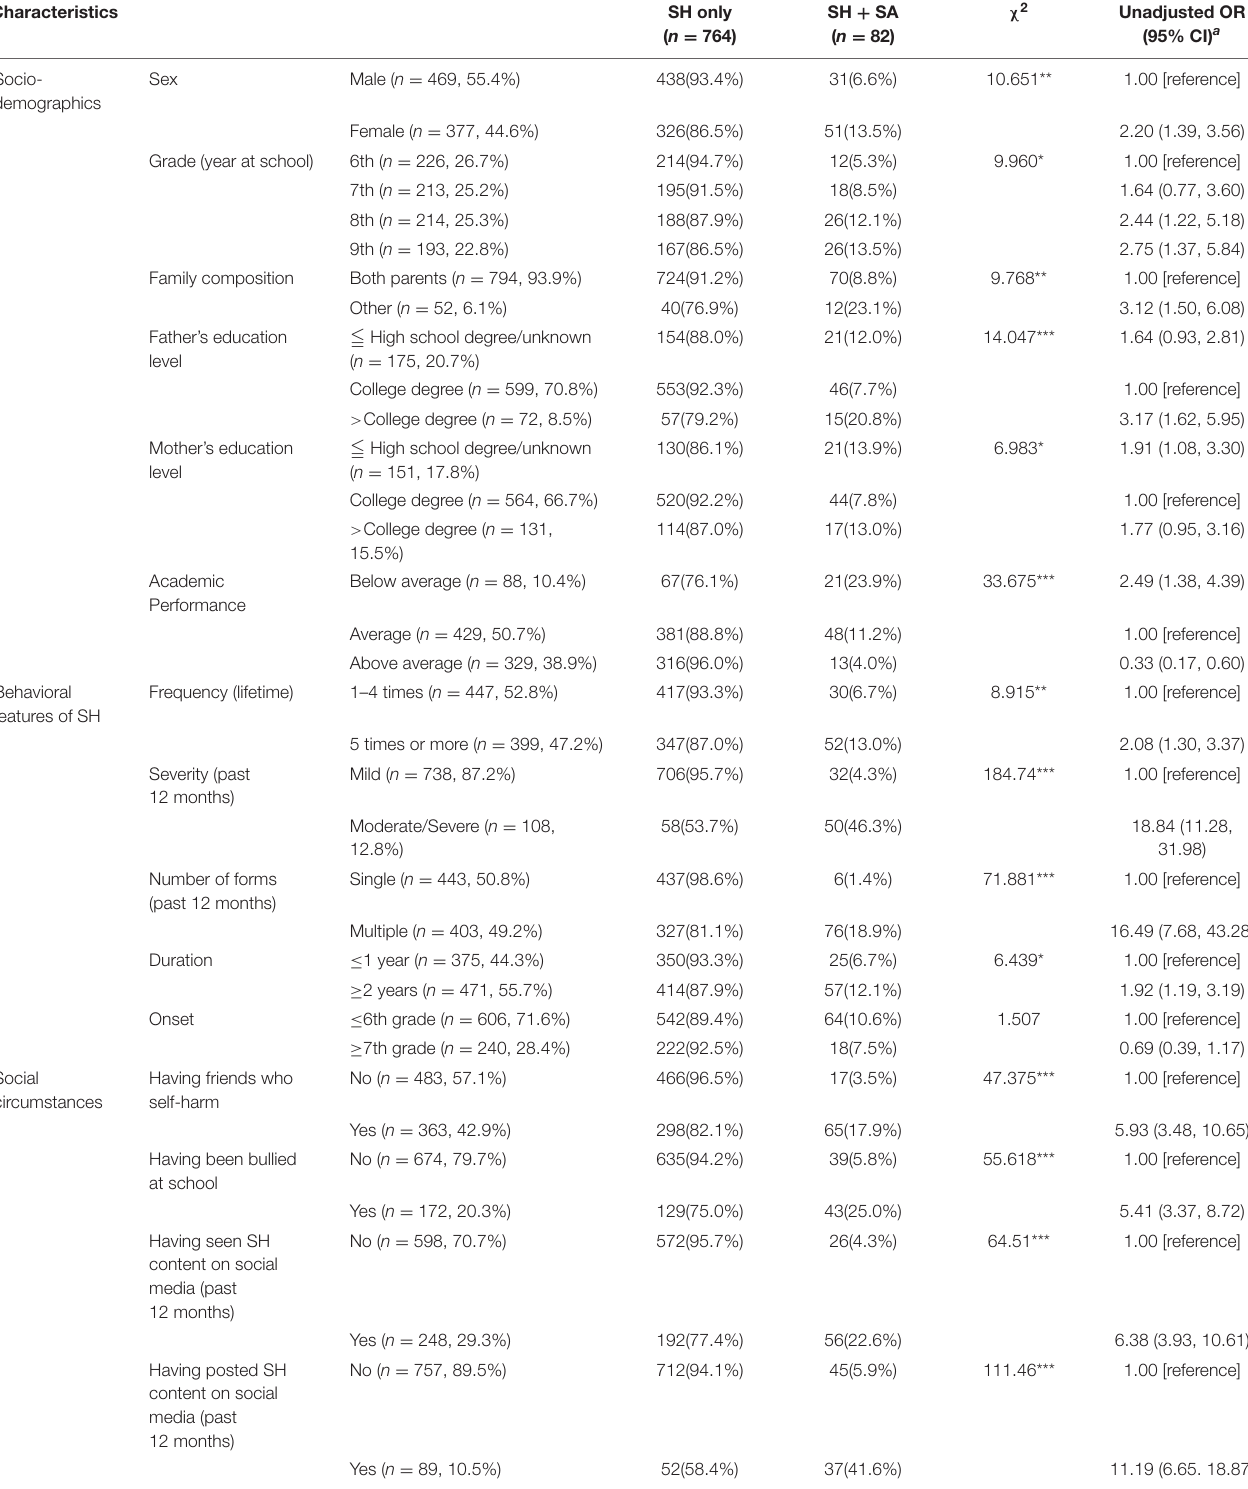
TABLE 3 | Characteristics of the subsample and associations with lifetime SA ( n = 846).